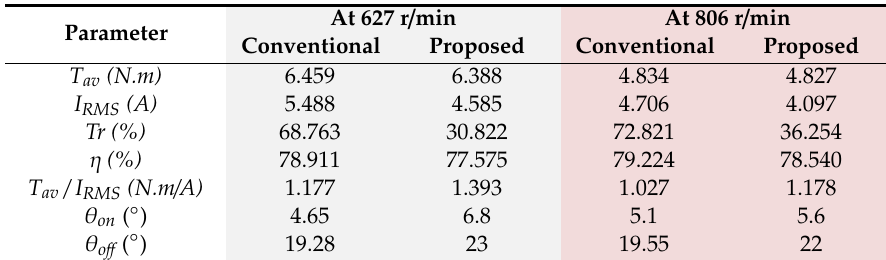
Table 3. Comparison between the proposed simplified average torque control (SATC) and conventional ATC